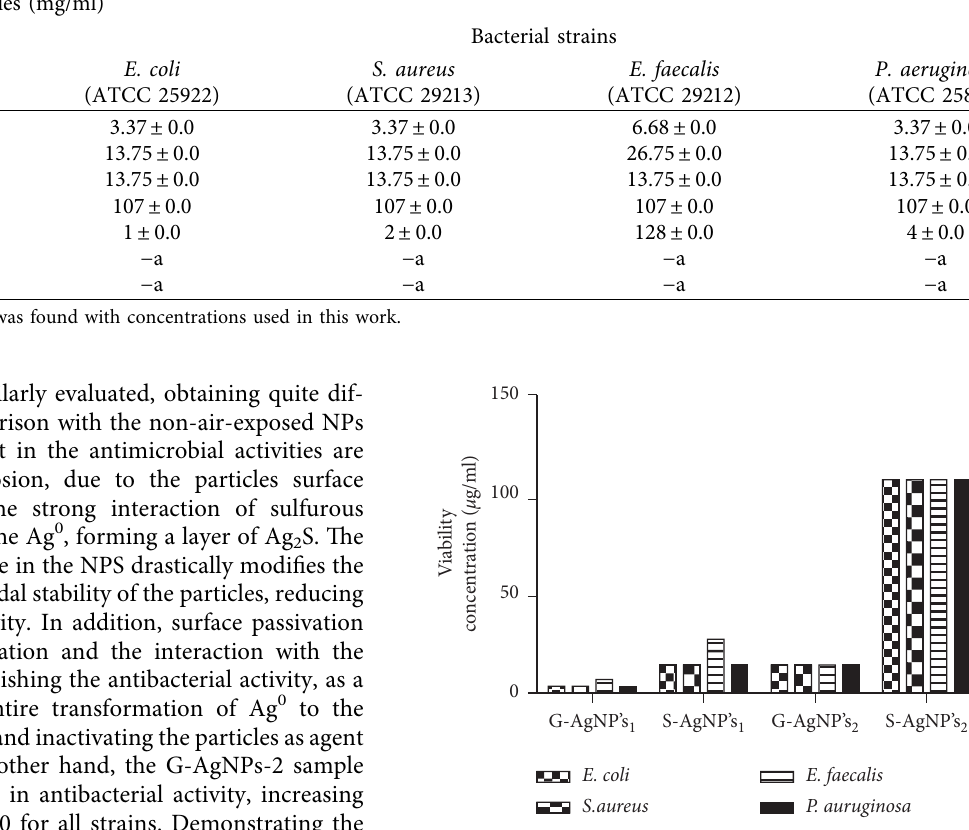
Figure 7: Comparison of bactericidal activity of Ag nanomaterials before and after atmospheric exposure (corrosion